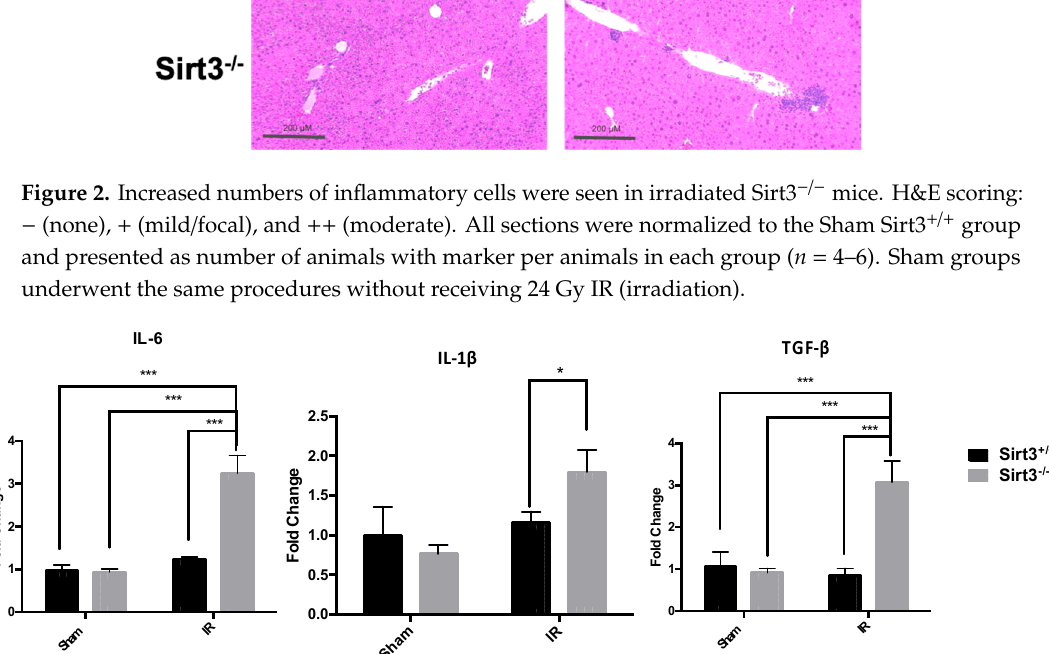
Figure 2. Increased numbers of inflammatory cells were seen in irradiated Sirt3 − / − mice. H&E scoring: − (none), + (mild/focal), and ++ (moderate). All sections were normalized to the Sham Sirt3 +/+ group and presented as number of animals with marker per animals in each group ( n = 4–6). Sham groups underwent the same procedures without receiving 24 Gy IR (irradiation).